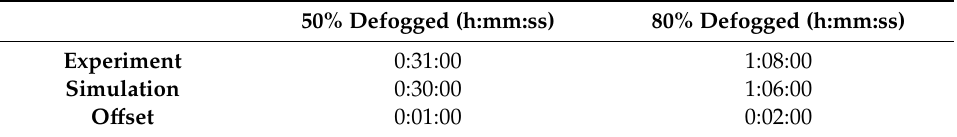
Figure 11. Development of defogging in C1.5 according to the experiment and the simulation.